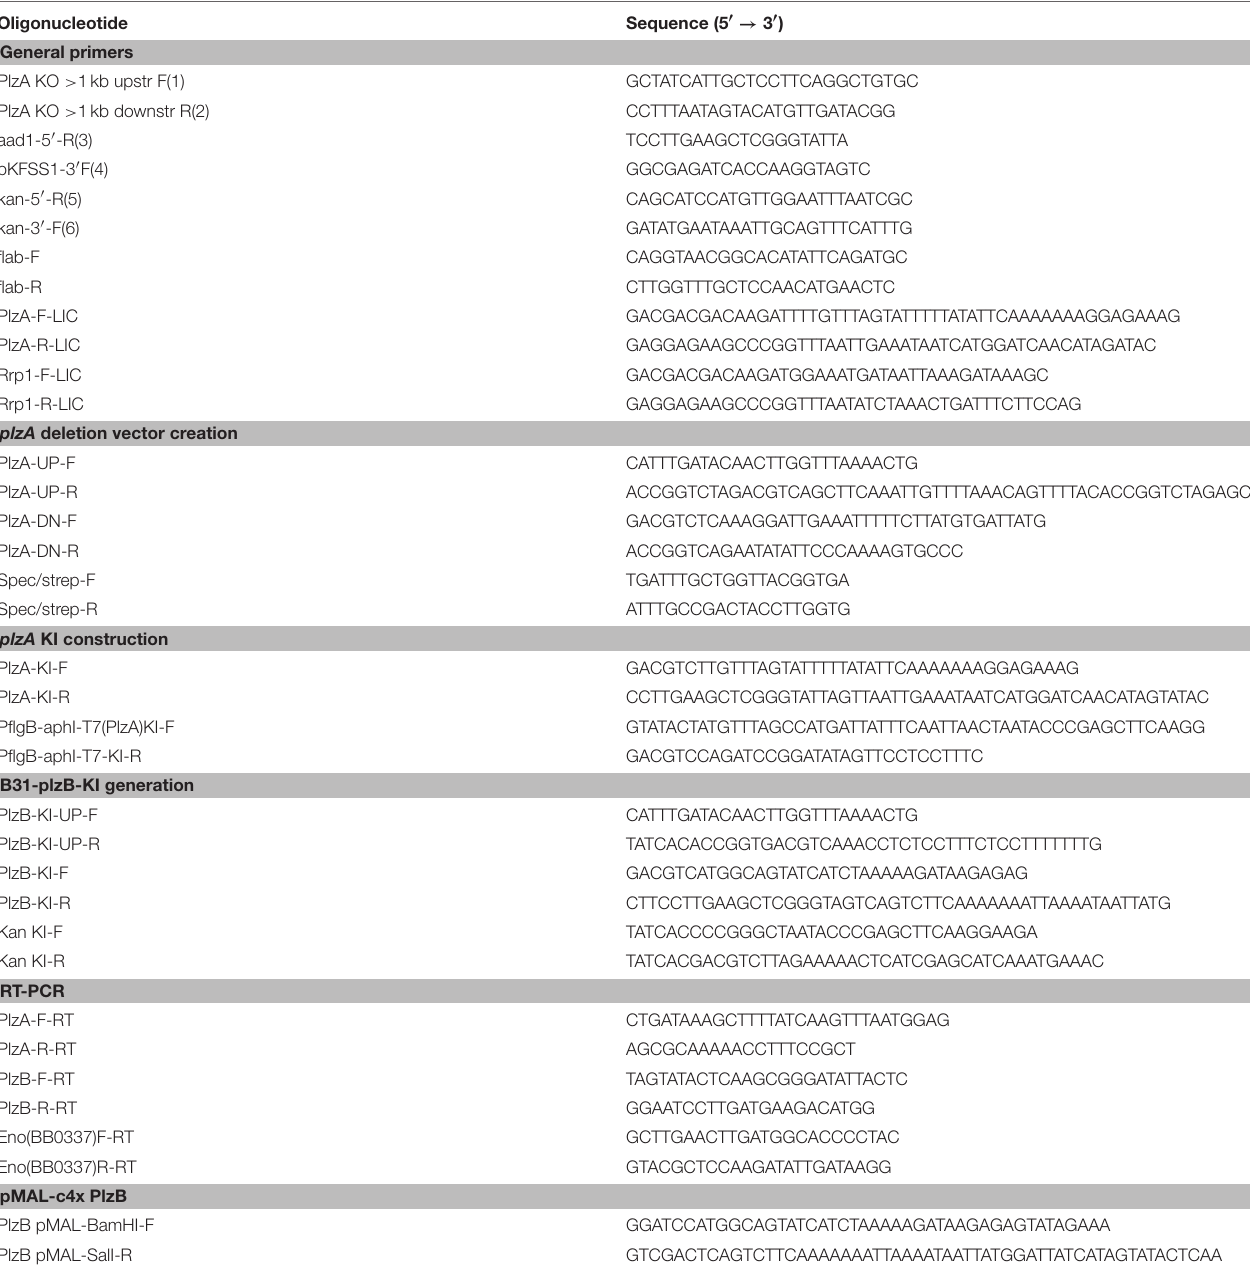
TABLE 1 | Oligonucleotides used in this study. Oligonucleotide Sequence (5 ′ → 3 ′